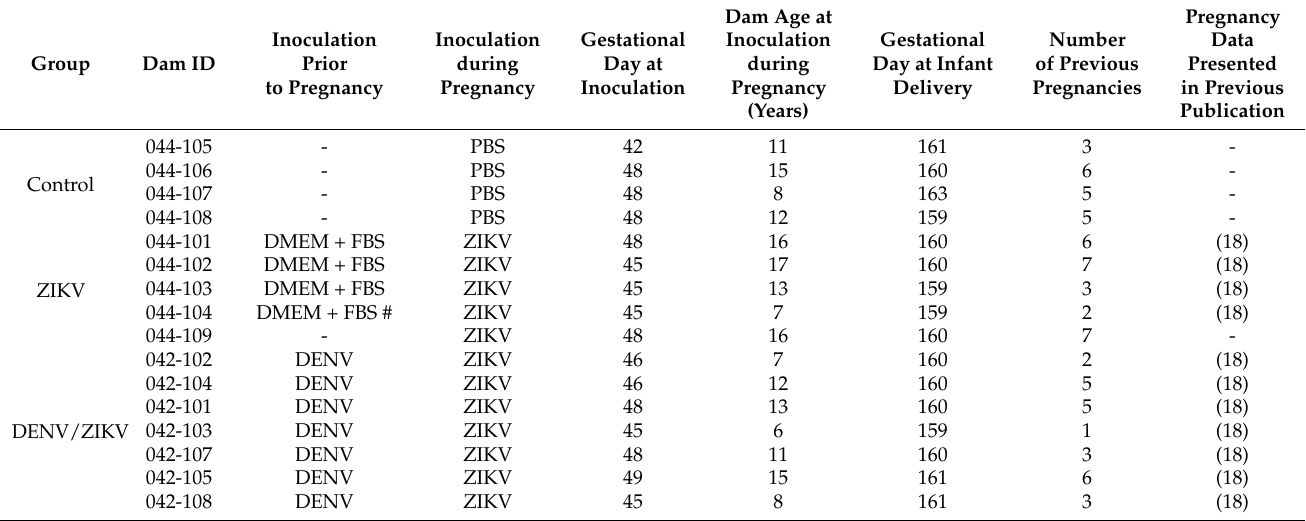
Table 1. Maternal medical and inoculation